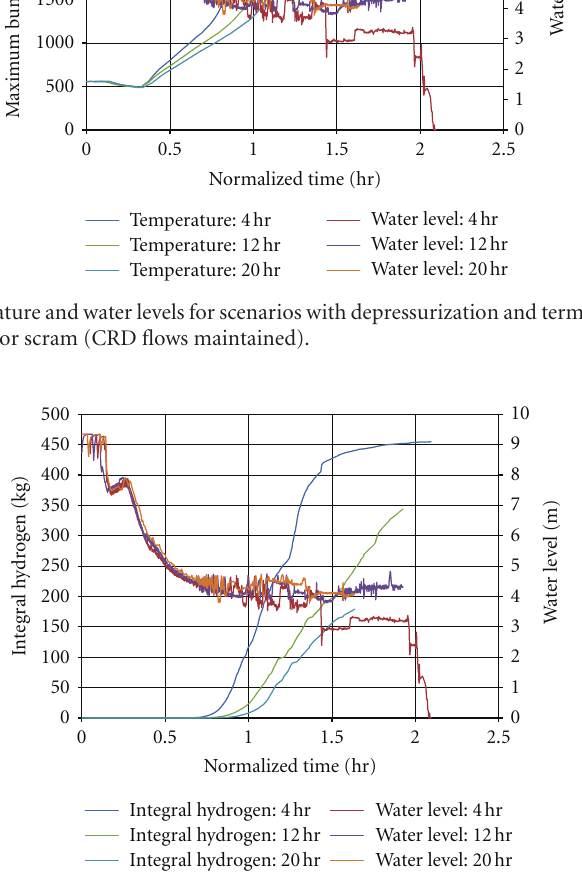
depressurization, fuel melting can be reached within 2